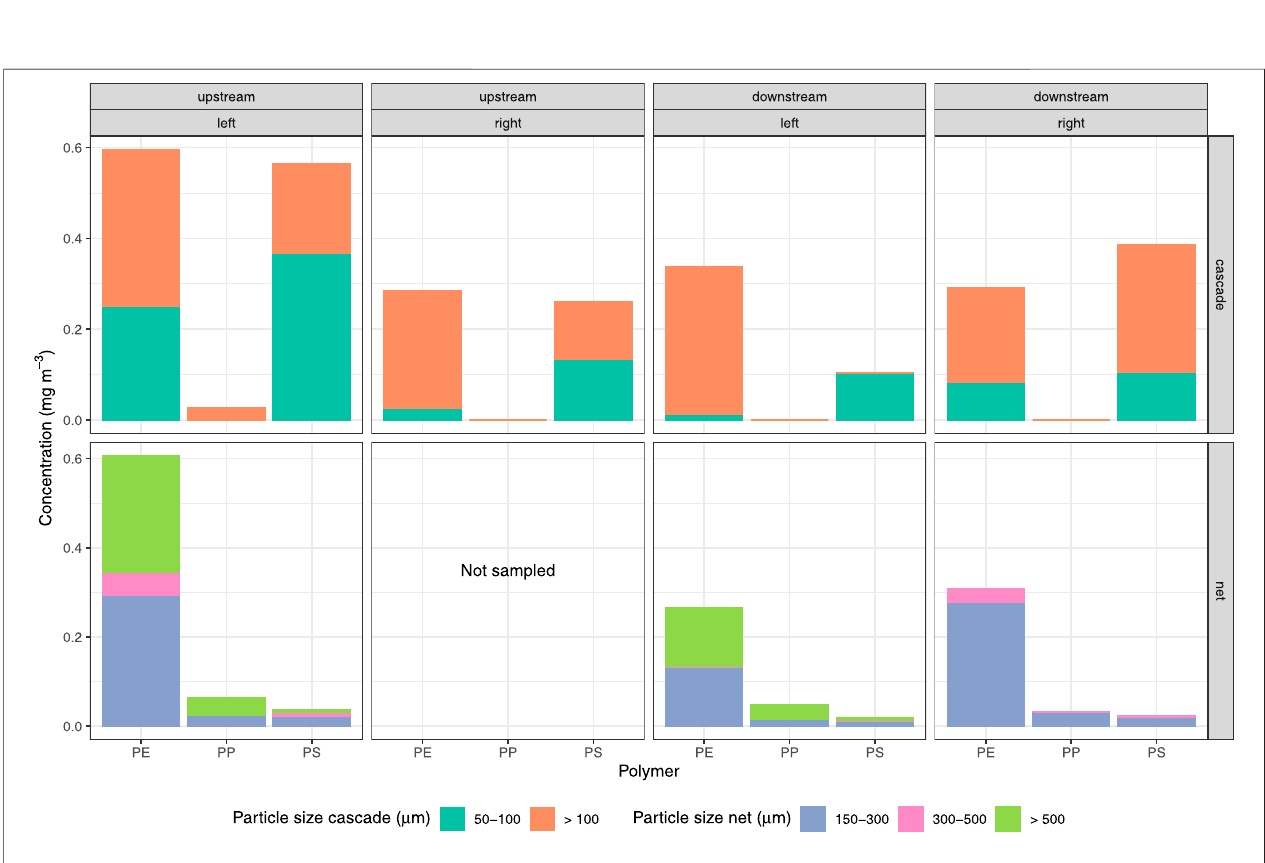
FIGURE 5 | Mass concentration of microplastics in water samples by